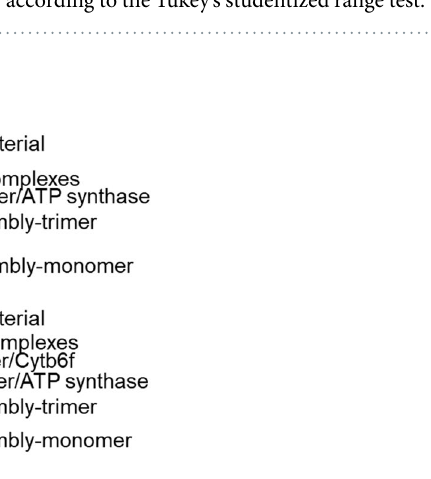
Figure 4. Changes in enzyme activities a RuBisCO activity b Sucrose synthase as affected by CO, NO x , CH 4 and C